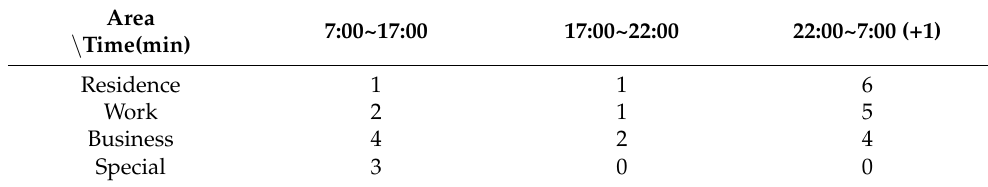
Table A4. Stay time of taxis in different areas on weekdays.